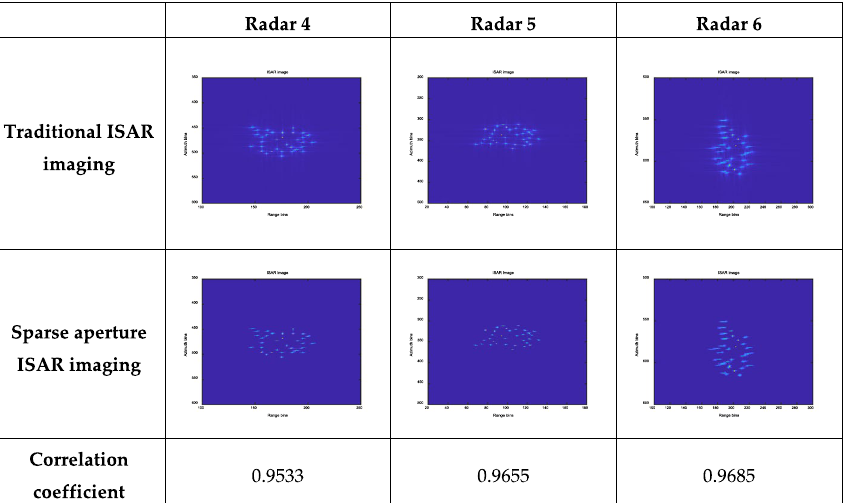
Table 4 Image comparison of different imaging